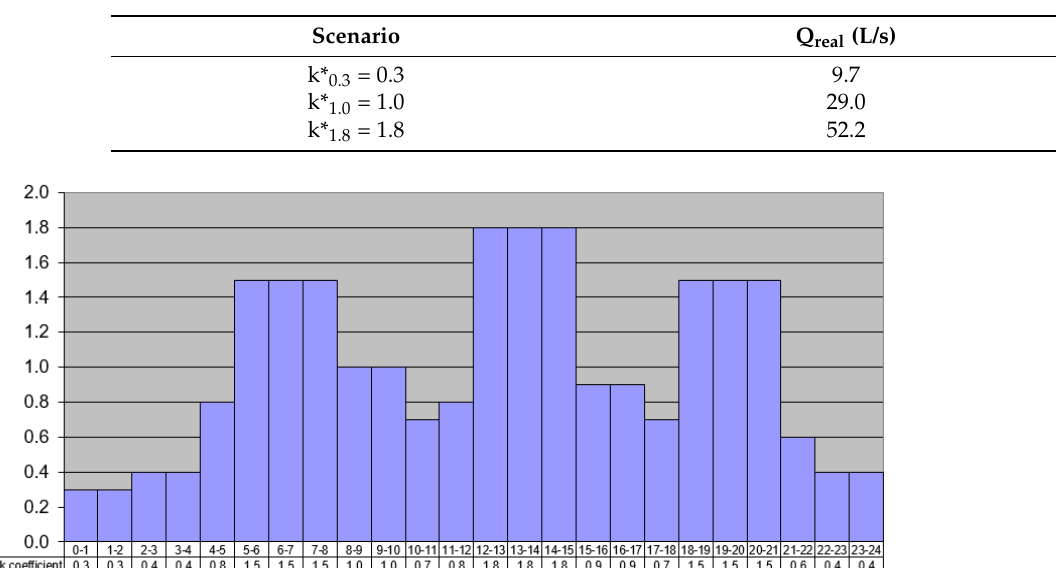
Table 1. k* i values and corresponding Q real .